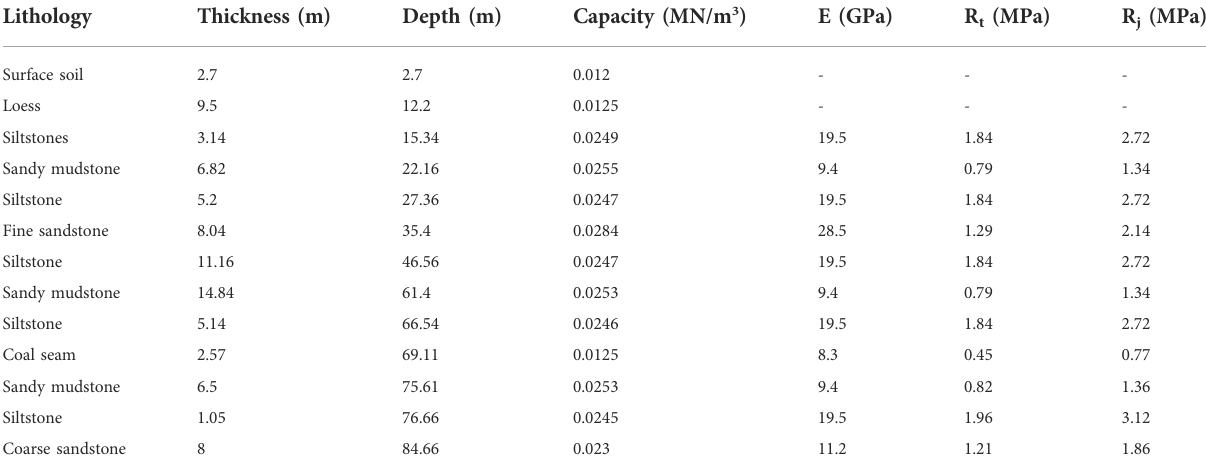
TABLE 5 Rock mechanics parameters of the Dingjiaqu coal mine. Lithology Surface soil